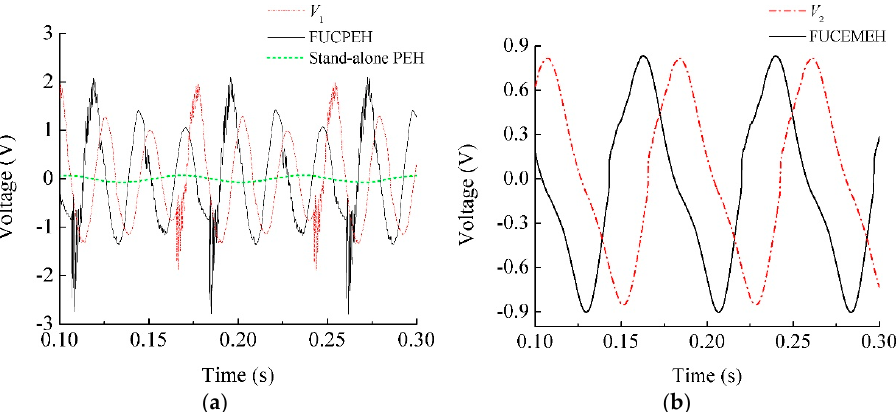
Figure 12. Comparison of output voltages at 13 Hz and 1 m/s 2 . ( a ) Voltages from the PEH subsystem, FUCPEH and stand-alone PEH; ( b ) Voltages from the EMEH subsystem and FUCEMEH.